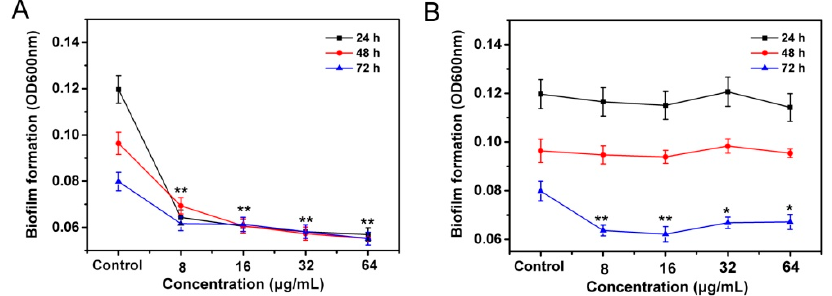
Figure 6. Effects of resveratrol ( A ) and coumarin ( B ) at different concentration on biofilm formation of R. solanacearum . Error bars represent the standard deviation ( n = 3). * and ** indicate p < 0.05 and p < 0.01, respectively.